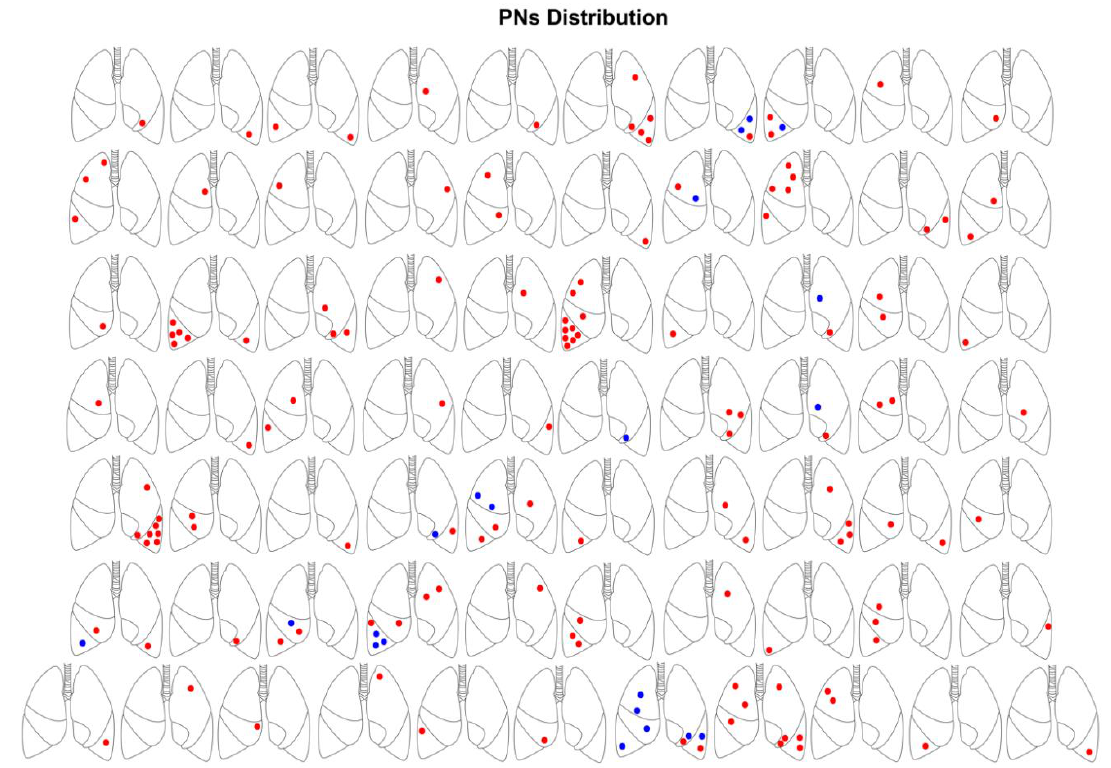
Figure 2. PNs, pulmonary nodules. Schematic distribution of pulmonary nodules among patients. Red nodules were malignant, blue benign at histological examination.